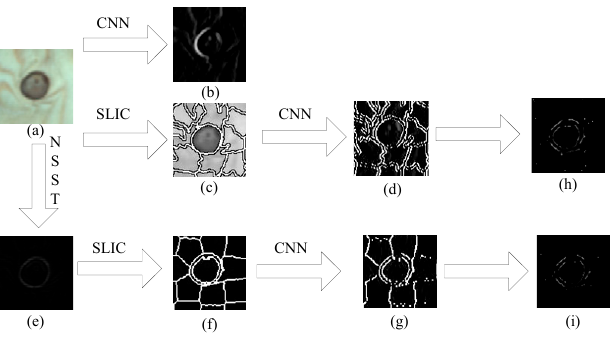
Figure 3. Contrast diagram of optimized CNN feature extraction effects.